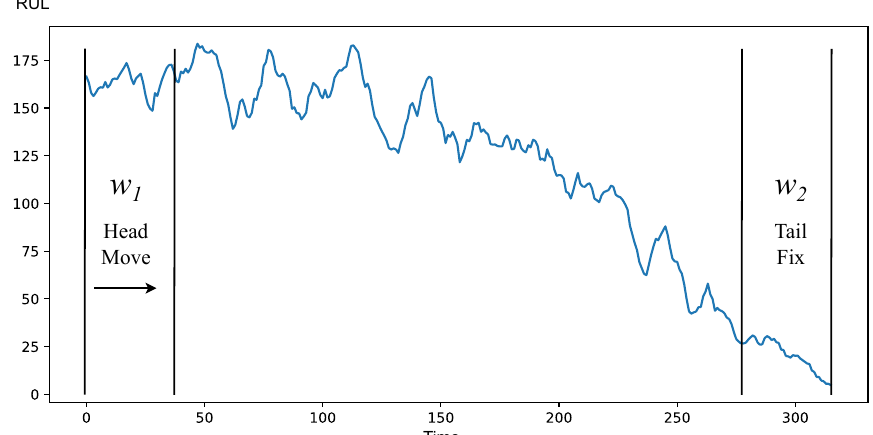
Figure 6. Explanation of HMTF strategy. We observe that one sliding window of observation from head is moving while the sliding window from tail is fixed.